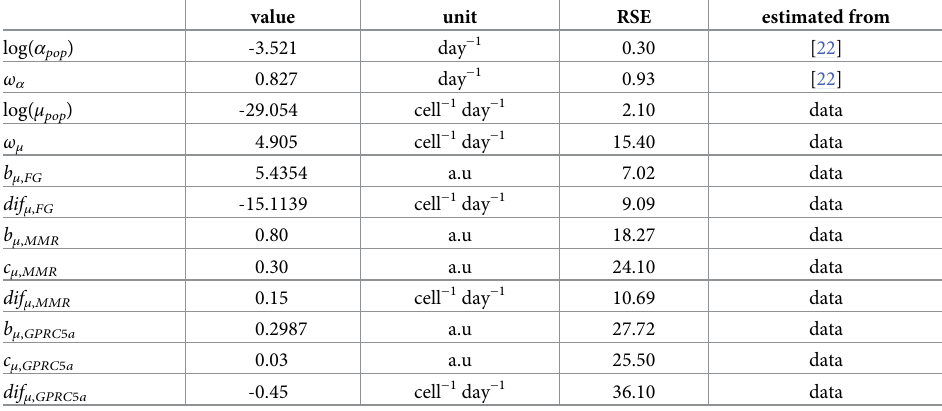
Table 2. Estimated parameters values. The parameter dif μ , c has been set to compensate for the unknown value of the parameter μ pop when studying the covariate c ( μ pop , c = μ pop + dif μ , c ). a.u. = arbitrary unit. RSE = relative standard